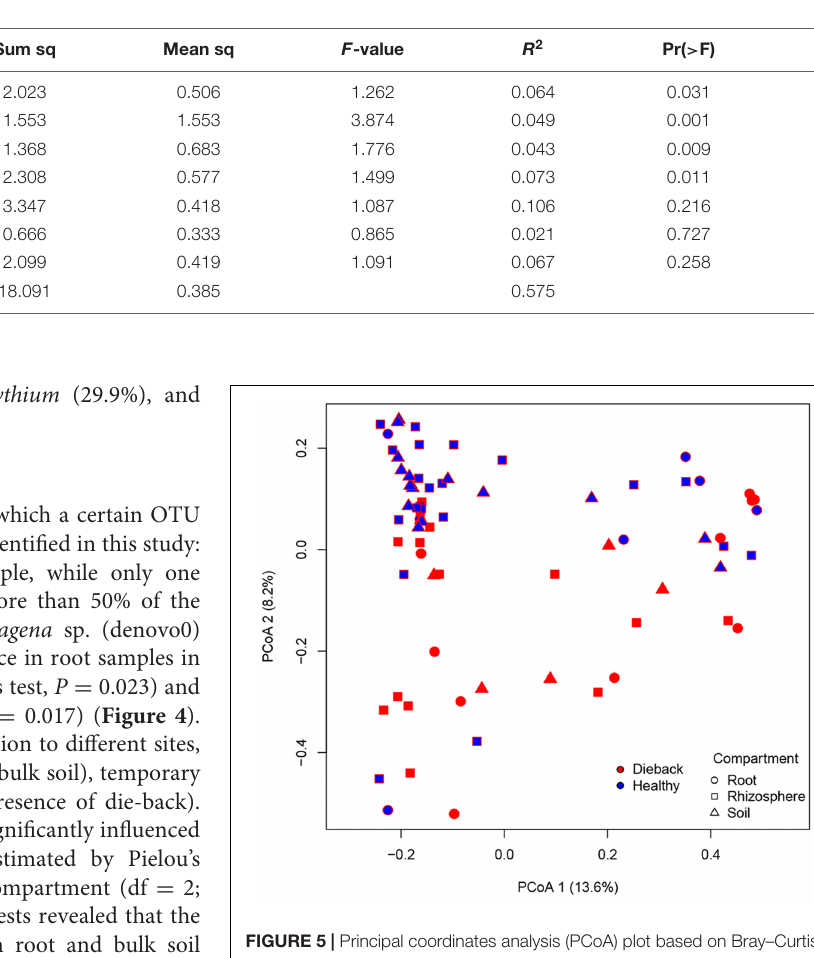
TABLE 2 | Results from permutational multivariate analysis of variance to test the effect of heavy metals in the soils on oomycetes communities. Variable